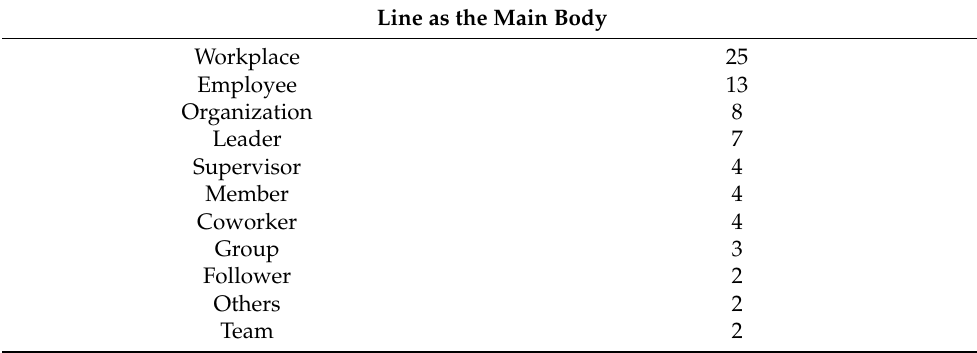
Table 4. Frequency and categories of subject research theme terms for leadership and envy